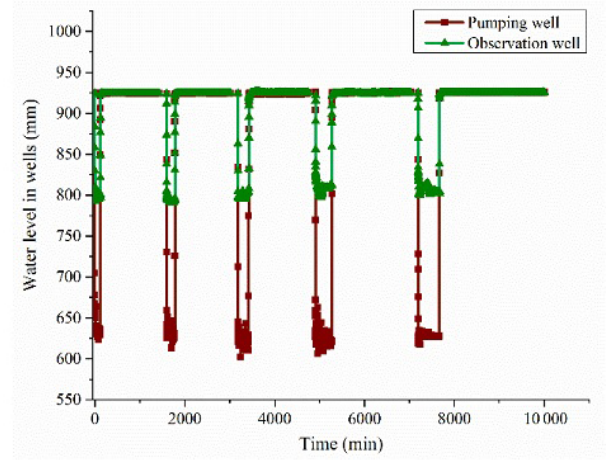
Figure 3. Diagram of water level in wells during intermittent pump- ing